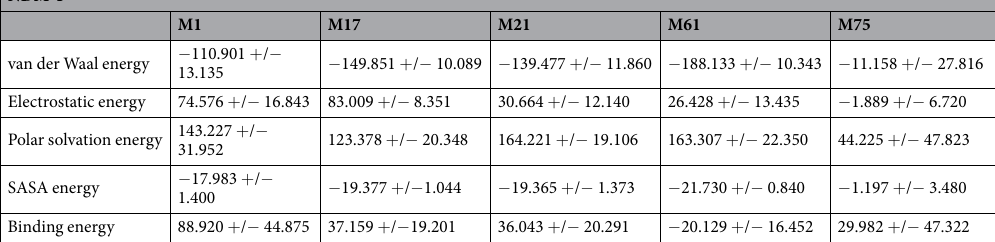
Analysis of the steady state kinetics parameter. The enzyme kinetics parameter, Km, Vmax and Kcat values for purified protein NDM-1 and each of these antibiotics (meropenem and imipenem), were calculated. The inhibitor of the NDM-1(M1, M17, M21, M61, M75) were carried out as per the concentration of IC50 value in the reaction, represented by Michaelis-menten equation (Fig. 4A,B) whereas, the kinetic parameters are sum- marized in Table 6. Kinetics parameters of NDM-1 represented the hydrolytic profile that is a feature of molecular class A and class B type β -lactamases, respectively. The enzyme kinetics parameter showed good affinity and catalytic activity with all the antibiotics, imipenem and meropenem (Km in 20 to 200 μ M range). Different drugs in combination with different inhibitors showed varying affinity with NDM-1 as shown in Table 6.